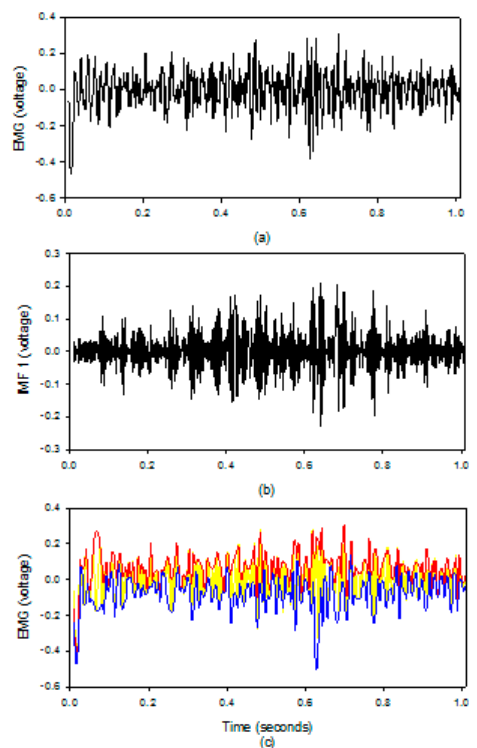
Figure 5. The results of the EMD algorithm on the EMG patch; ( a ) the raw EMG, ( b ) the IMF1 of the EMG, ( c ) the upper (red) and lower (blue) envelopes of the EMG, and the middle (yellow).